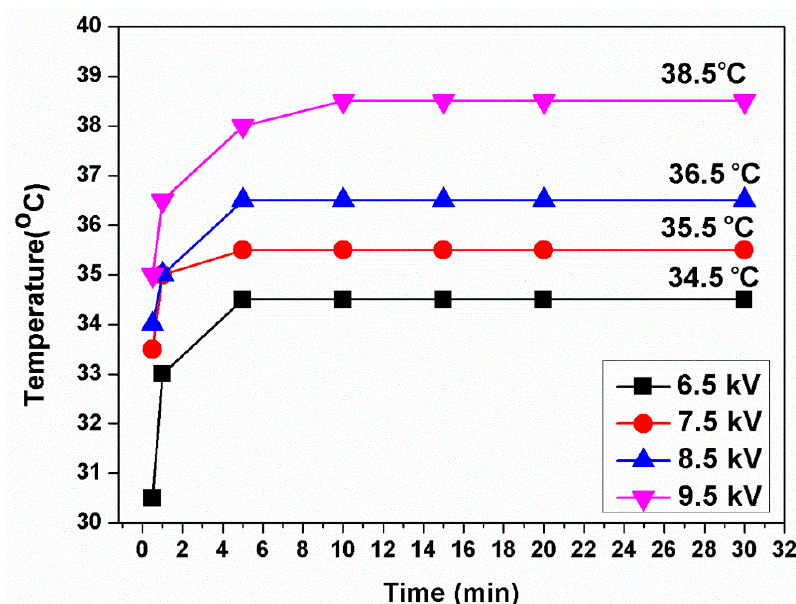
Figure 2. CAPJ temperature keeps steady for at least 30 min. Temperature changes of CAPJs operated at di ff erent applied voltages ranging from 6.5 to 9.5 kV under a fixed He gas flow rate of 5 slm. The temperature was detected at the position of 1 cm below the downstream of CAPJ.